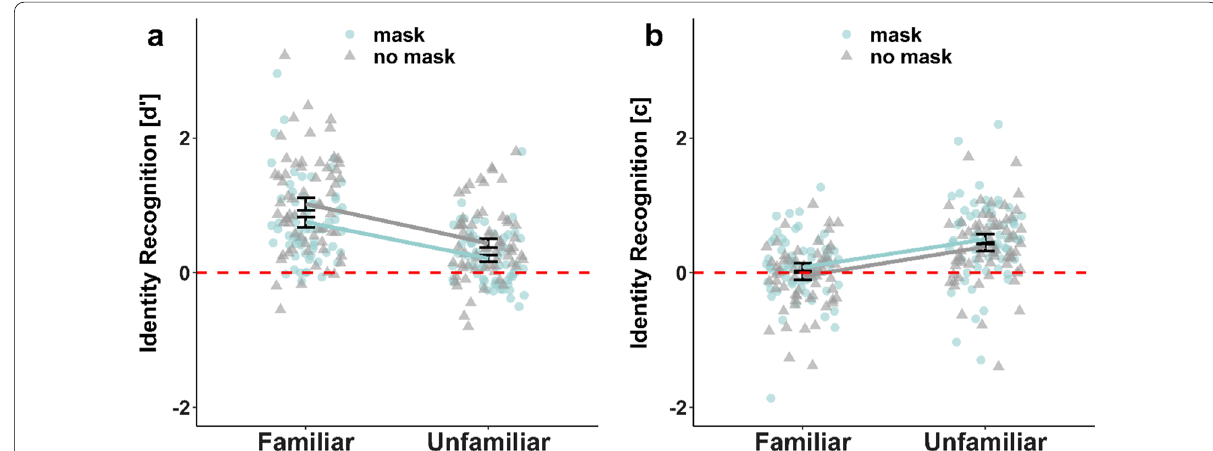
Fig. 5 Sensitivity ( d ′ ) and response bias ( c ) for identity recognition (Question 1). Note. Error bars indicate standard errors. Each data point shows the sensitivity ( d ′ ; panel a ) or response bias ( c ; panel b ) of a single participant indicating whether they saw a face in the study phase, separately for familiar and unfamiliar faces and faces that wore a mask (blue dots) or not (gray dots) in the study phase. a Main effects of familiarity and masks on recognition sensitivity for faces. Higher values of d ′ indicate better performance. A value of zero indicates ‘guessing.’ b Main effects of familiarity and masks on recognition bias for faces. Values greater than zero indicate a conservative bias (tendency to answer ‘no’) and values lower than zero indicate a liberal bias (tendency to answer ‘yes’)